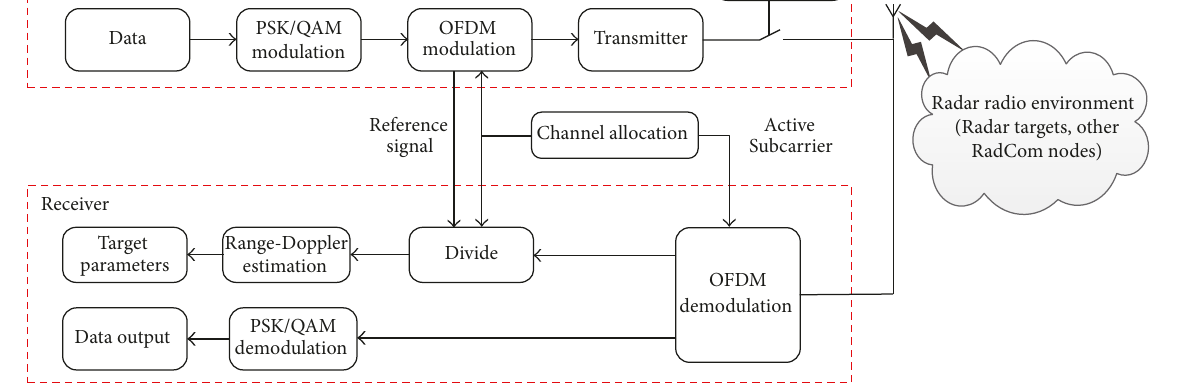
Figure 2: RadCom node architecture.